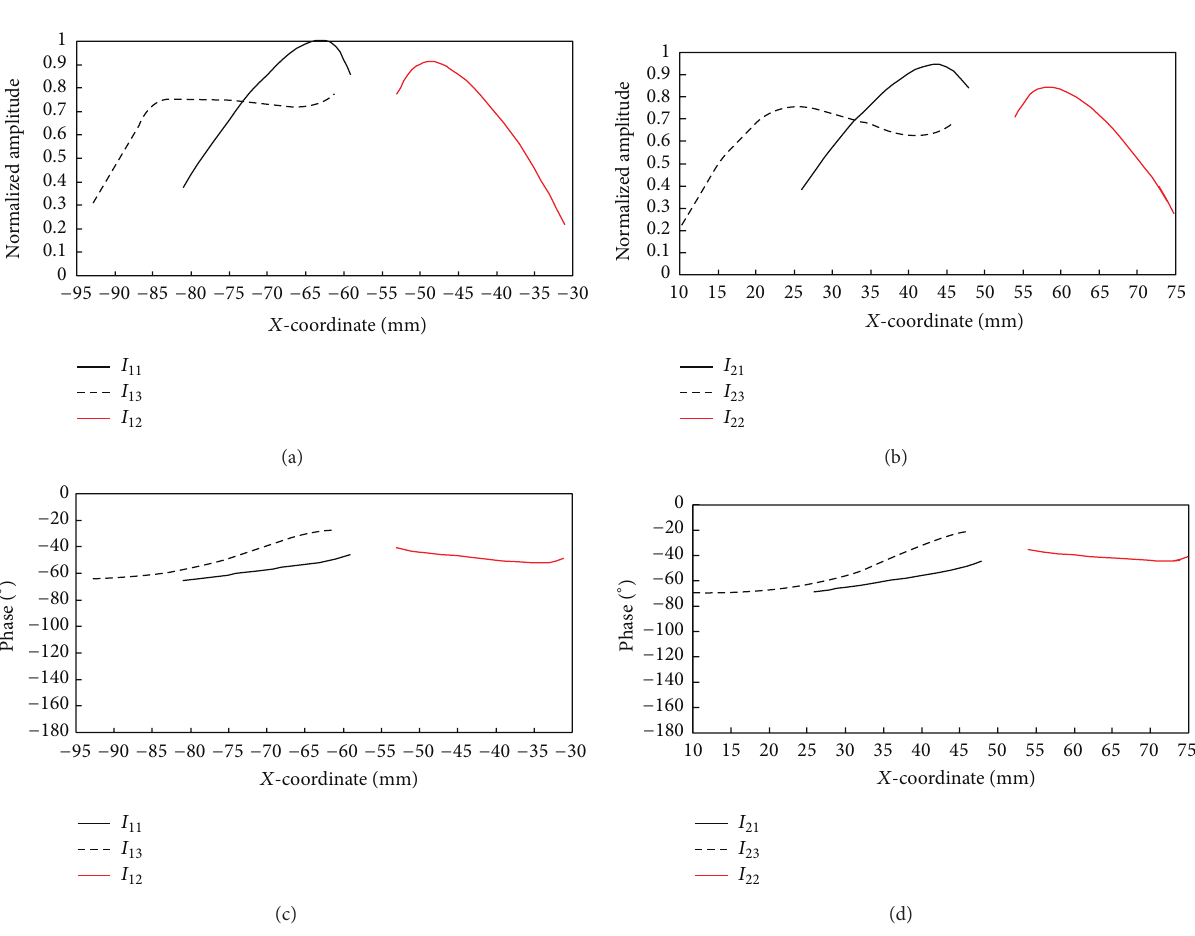
Figure 4: Current distribution on active dipoles and loading metal strips (at 2.0 GHz): (a) current amplitude distribution on element 1, (b) current amplitude distribution on element 2, (c) current phase distribution on element 1, and (d) current phase distribution on element 2.